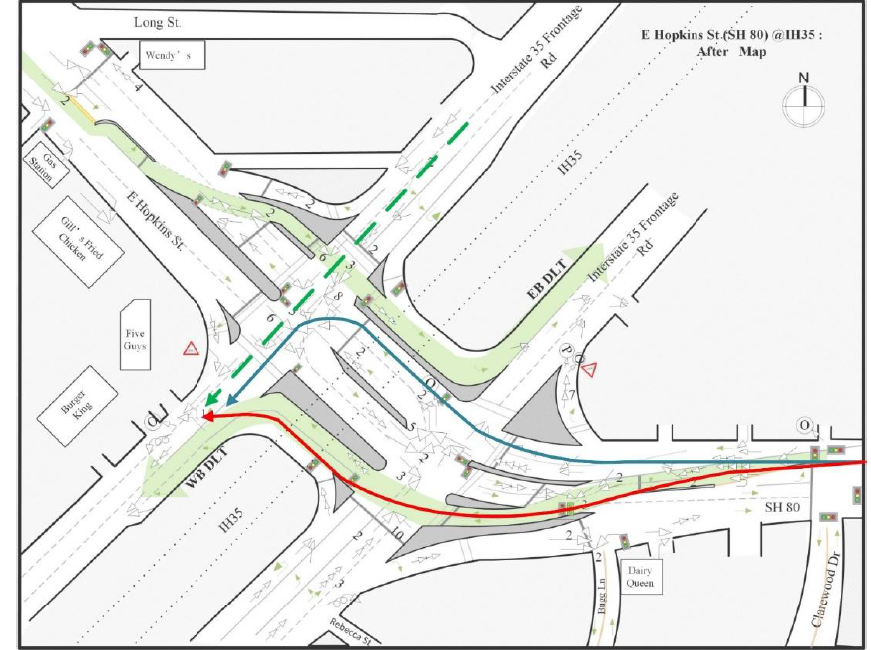
Figure 6. Comparison of the paths of southbound left-turn vehicles before and after the implementation of DLT.